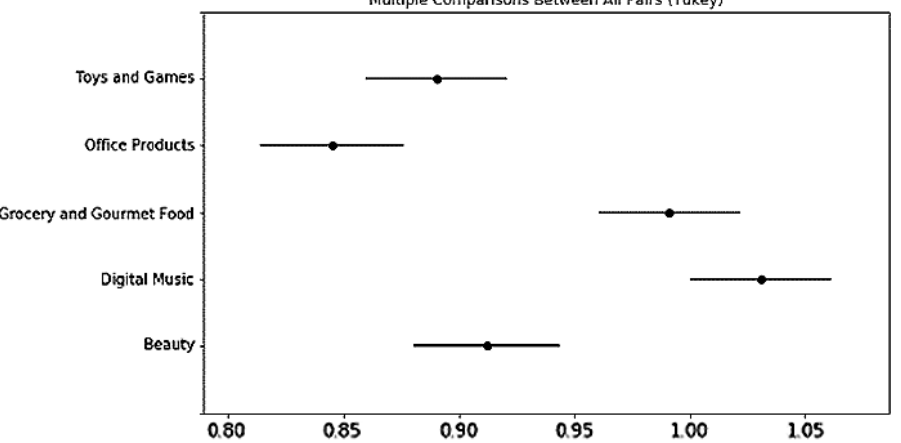
Figure 8. Multiple comparisons between all pairs (Tukey) in product categories for psychographic variable segmentation-based rating prediction (RMSE).